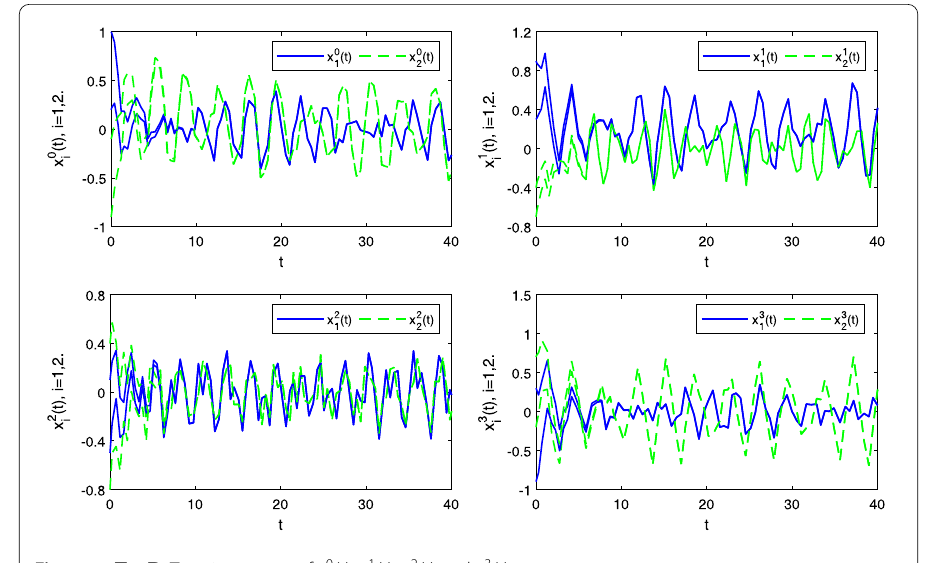
Figure 1 T = R . Transient states of x 0 ( t ), x 1 ( t ), x 2 ( t ) and x 3 ( t )